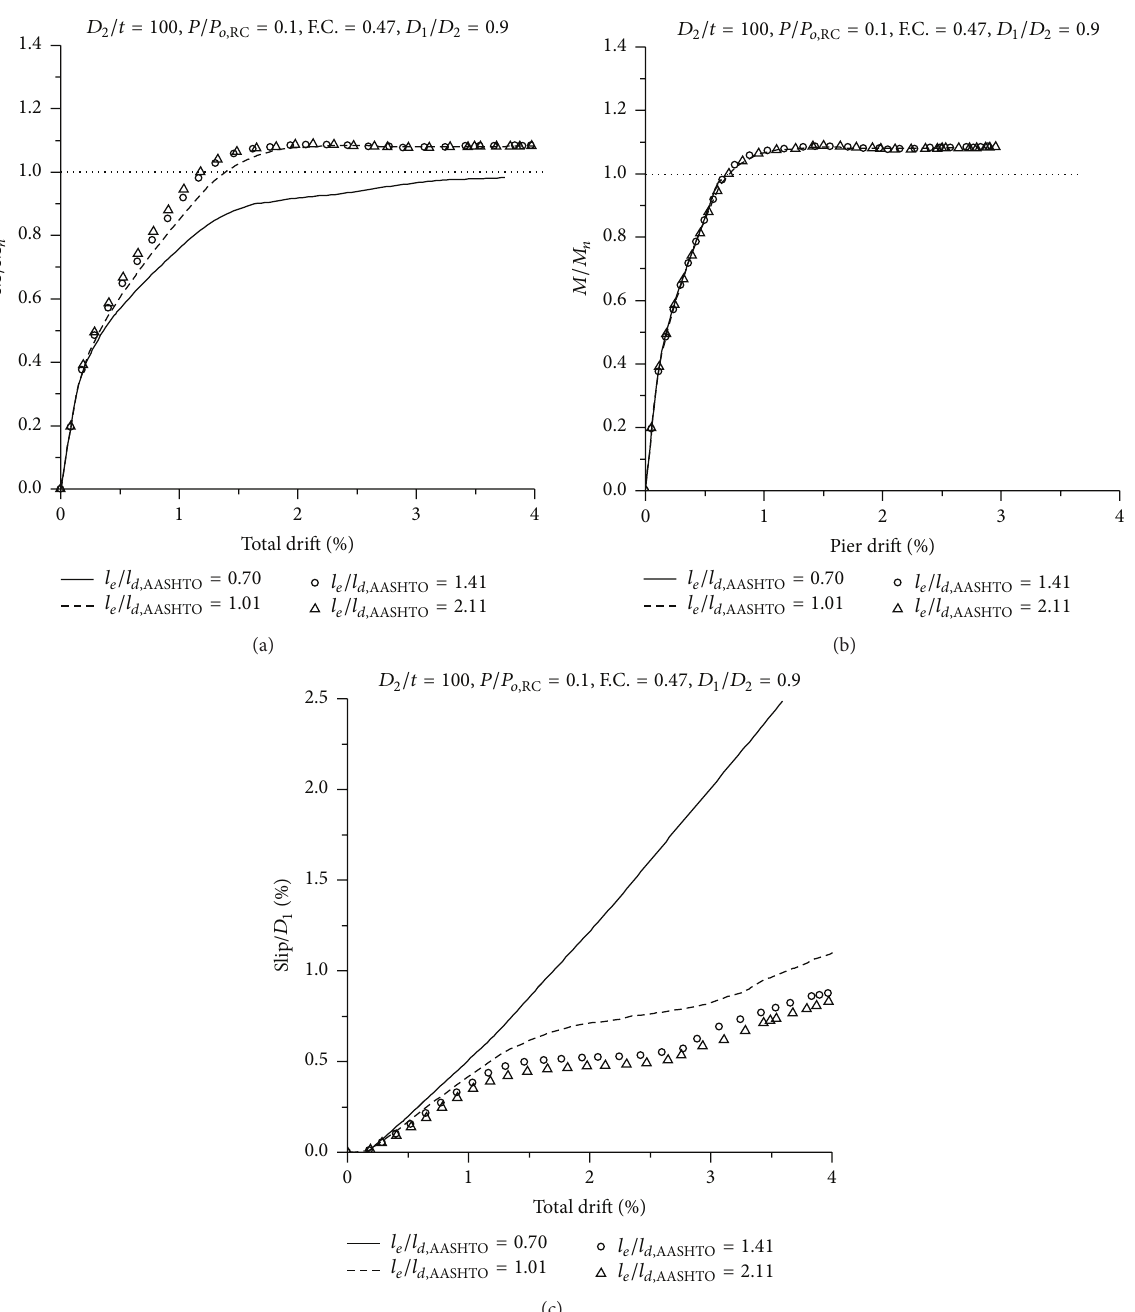
varies from 0.3 to 0.6, and the mean value is equal to